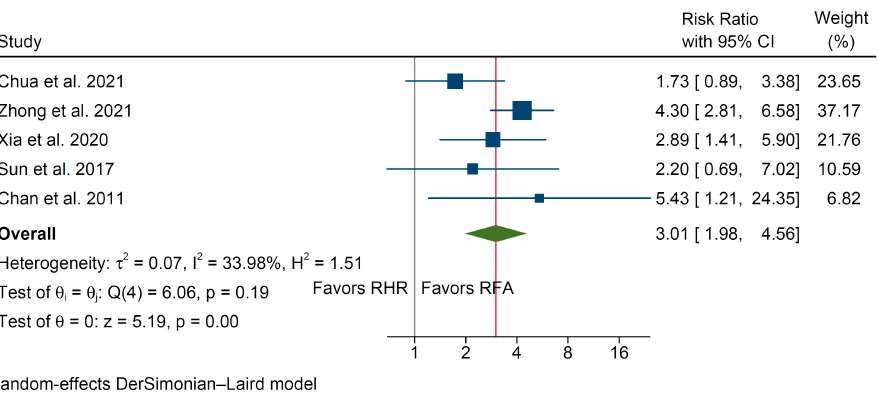
Figure 5. Forest plot of overall morbidity between the RHR and RFA groups [22,23,30,32,36]. Major (Clavien Dindo ≥ III) morbidity was assessed in 10 studies incorporating 1850 patients (791 in the RHR group vs. 1059 in the RFA group). Pooled results indicate significantly increased major morbidity in patients undergoing RHR (RR 3.65, 95% C.I. 2.07 to 6.43, p < 0.001, Figure 6) with non-existent interstudy heterogeneity (I 2 = 0%).